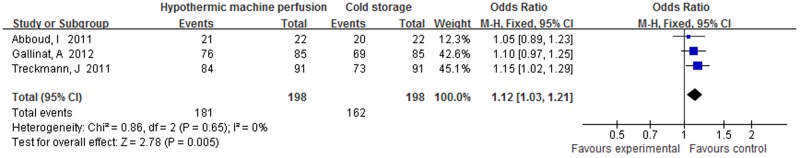
One-year graft survival for ECD kidneys preserved by HMP versus CS.